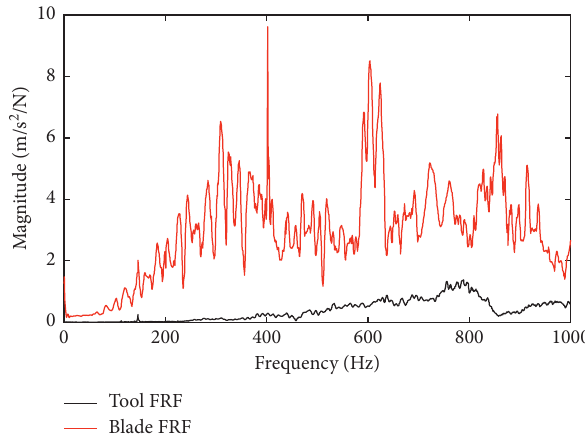
Figure 10: Comparison of FRF between the tool and the blade.